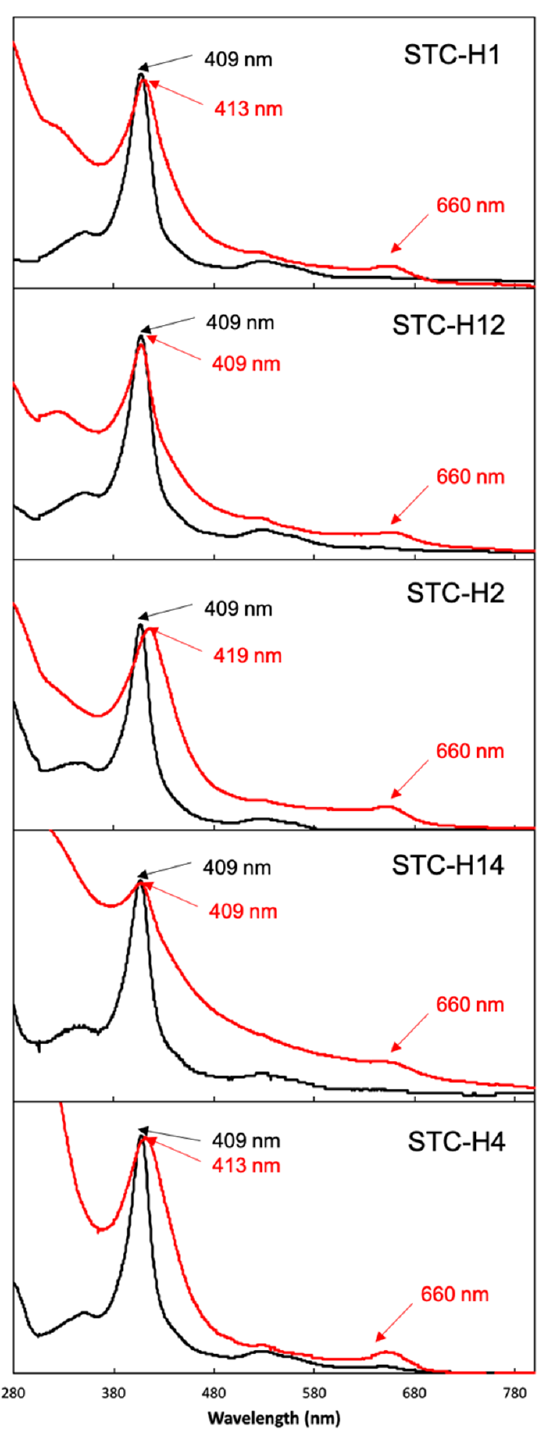
Figure 2. UV-visible spectra of STC mutants produced by System III (red) and System I (black). Table 1. Expected molecular weight (kDa) for the different STC mutants, determined from the mo- lecular mass of the total number of residues plus the molecular mass corresponding the heme group(s) (616.5 Da per heme). Grey shading represents the species detected by mass spectrometry. Mutant Apo Protein 1 Heme 2 Hemes